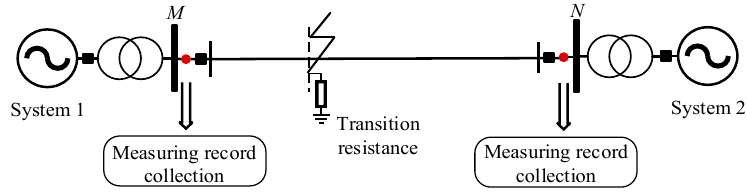
Figure 6. Simplified simulation diagram of the transmission system.